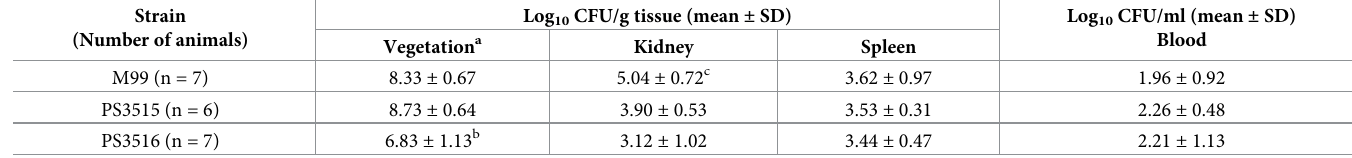
Table 2. Single strain infection model of endocarditis in rats, 72 h post-infection. Strain (Number of animals)